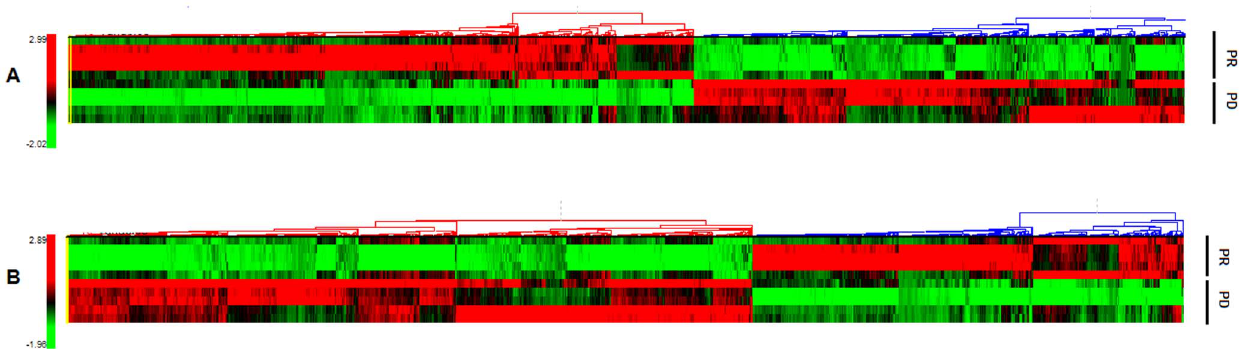
Figure 1. Heatmaps of lncRNA and mRNA expression patterns. RNA expression is depicted according to treatment response. (A) Hierarchical Clustering for ‘‘Differentially expressed lncRNAs’’. (B) Hierarchical Clustering for ‘‘Differentially expressed mRNAs’’. ‘‘Red’’ indicates high relative expression, and ‘‘green’’ indicates low relative expression.